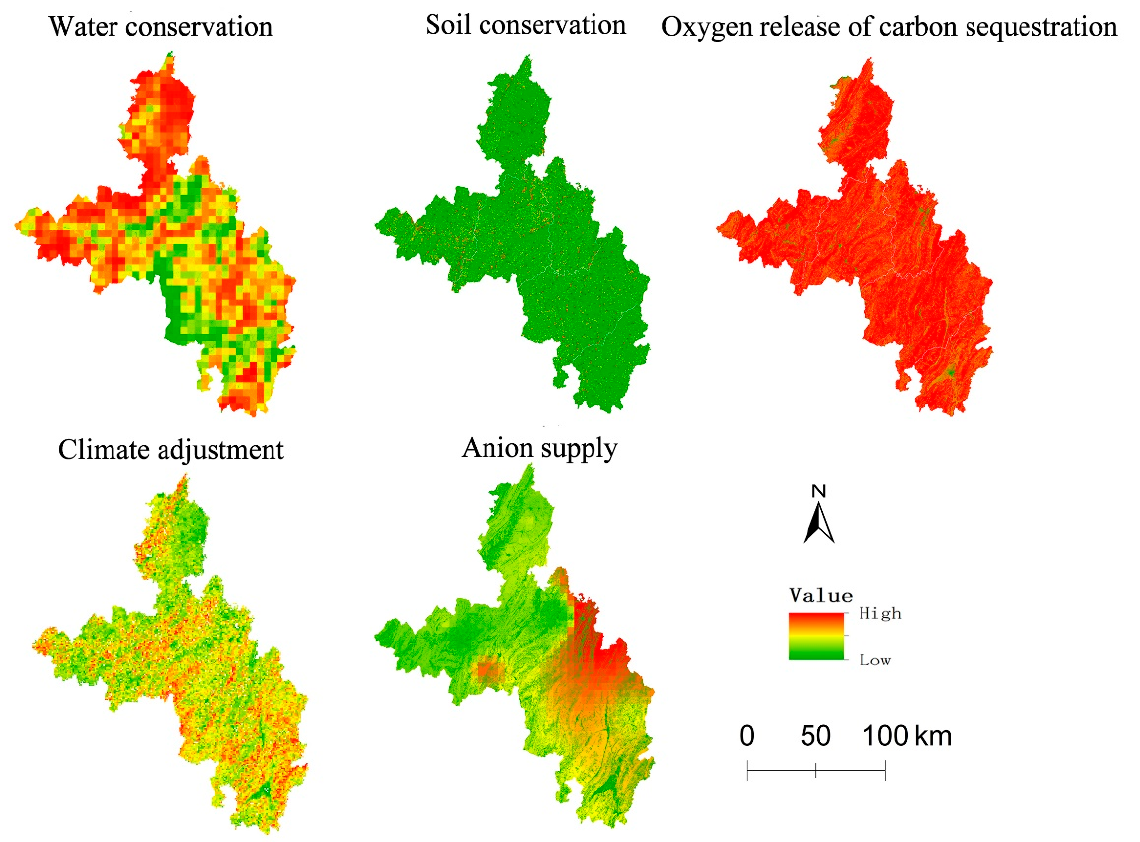
Figure 3. Distribution of ecosystem regulation services.